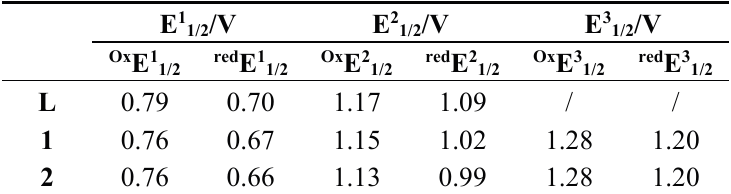
Table 3. Oxidation potentials (V vs. saturated calomel electrode, nBu 4 NPF 6 , 0.1 M